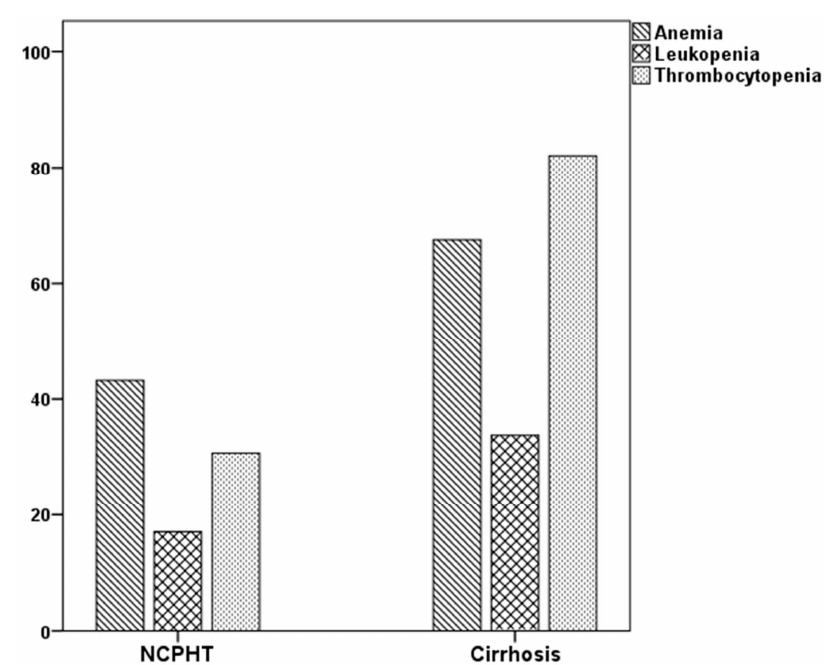
Figure 1. Percentage of cytopenias in patients with portal hypertension.